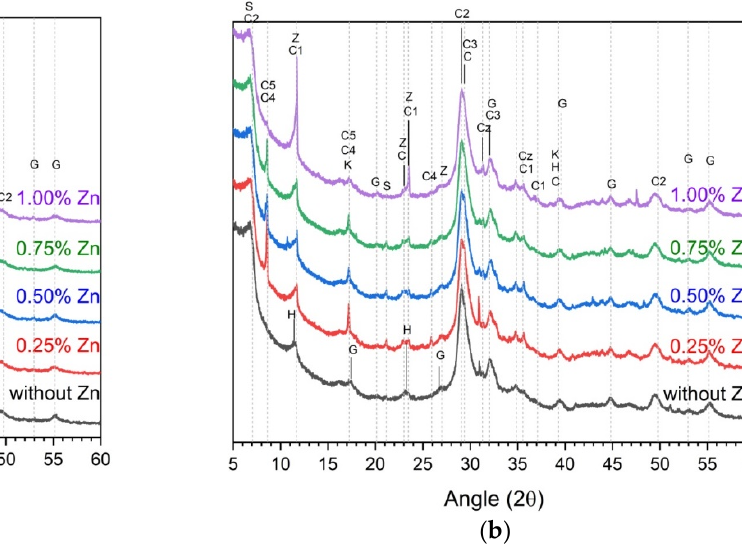
( d ) Figure 4. XRD analysis of samples with a w/b of 0.45 ( a ) cured at 23 ± 2 °C after 1 day, ( b ) cured at 23 ± 2 °C after 28 d, ( c ) cured at 40 ± 2 °C after 1 day, and ( d ) cured at 40 ± 2 °C after 28 d. 3.3. Microstructures Figures 5 and 6 show SEM images according to the w/b and curing temperature. The shapes of the foams observed in Figures 5 and 6 are not completely spherical but elliptical, formed by aeration [52,53]. Figure 5a–d shows the cross ‐ sectional SEM images of the sam ‐ ples cured at 23 °C, with a ZP concentration of 0.25–1.00%. Several voids were observed in the cross ‐ sectional view, and some were connected. Even with increased ZP concentra ‐ tion, the diameters of the pores did not change significantly, showing similar sizes. Figure 5e–f shows the cross ‐ sectional SEM images of the samples cured at 40 °C, with similar pore sizes and distributions regardless of the ZP concentration. The number of pores of such samples slightly increased compared with those cured at 23 °C. Figure 6 shows the cross ‐ sectional SEM images of the samples with a w/b of 0.45 according to the curing temperature. Figure 6a–d and 6e–h show the cross ‐ sectional SEM images of the samples cured at 25 °C and 40 °C, respectively. The diameters of the pores observed in the latter increased more than those observed in the former. Although the